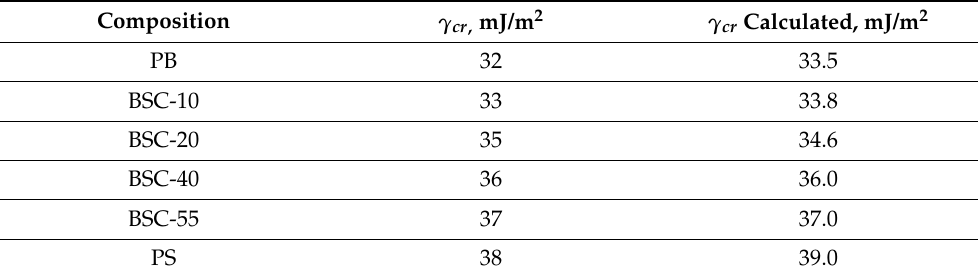
Table 3. Critical surface energies of copolymers according to Zisman. Composition